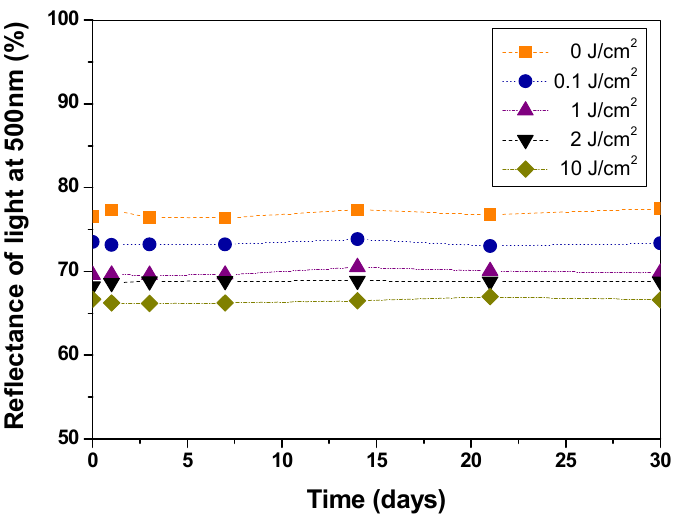
Figure 5. Long-term stability of paper doped with 20% of PAN–PDA fibres after irradiation with UVC light in the range 0 − 10 J/cm 2 (non-refined paper).